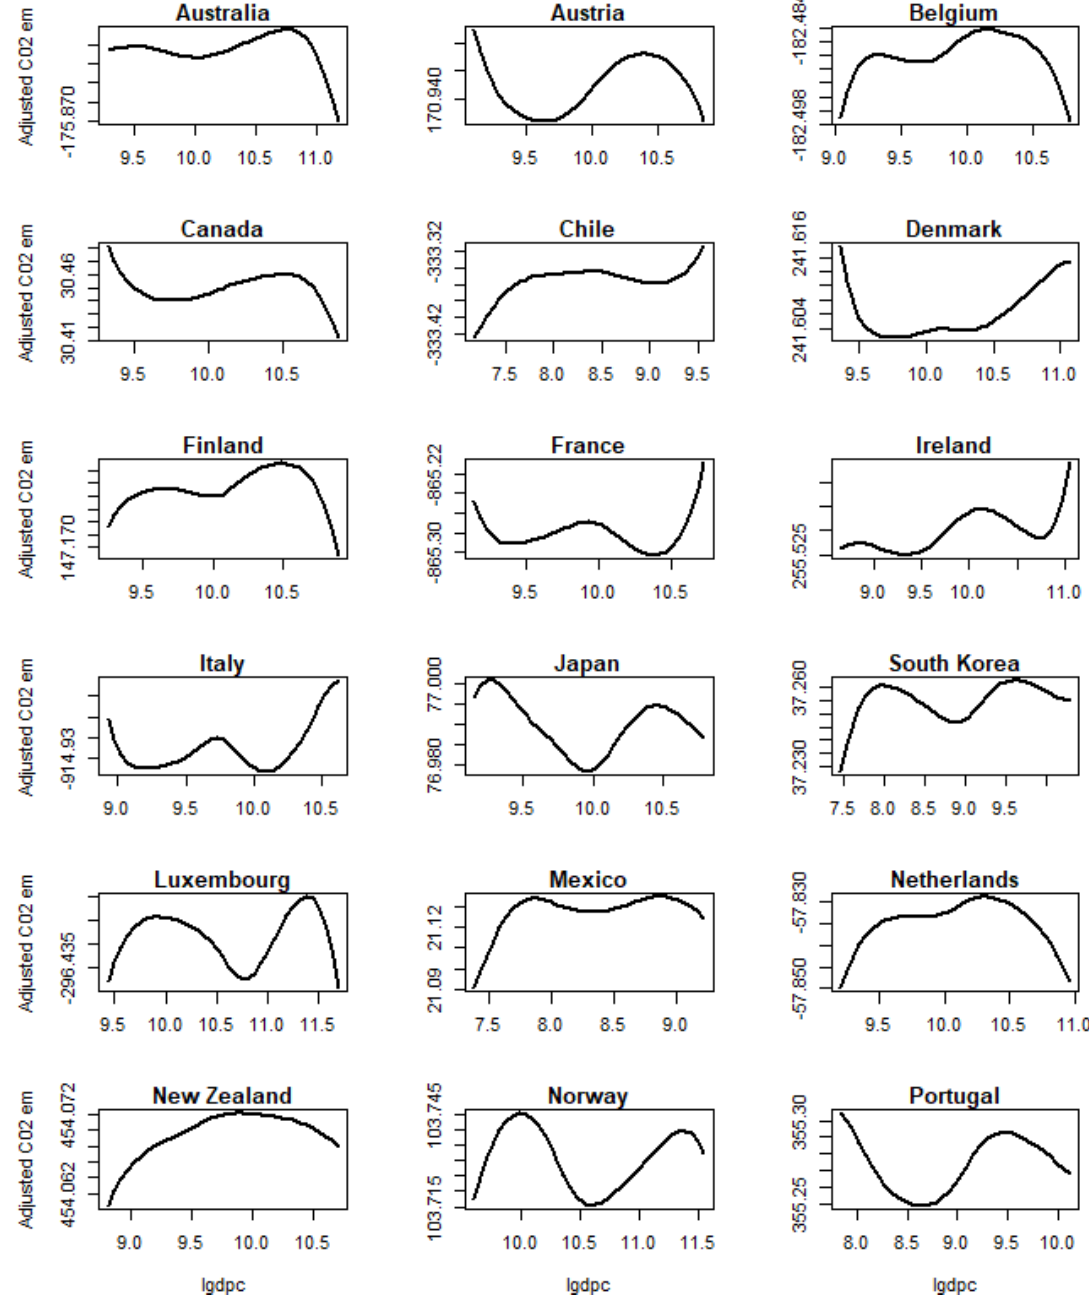
Figure 1. Nonparametric estimates of income-CO 2 emissions for the OCDE